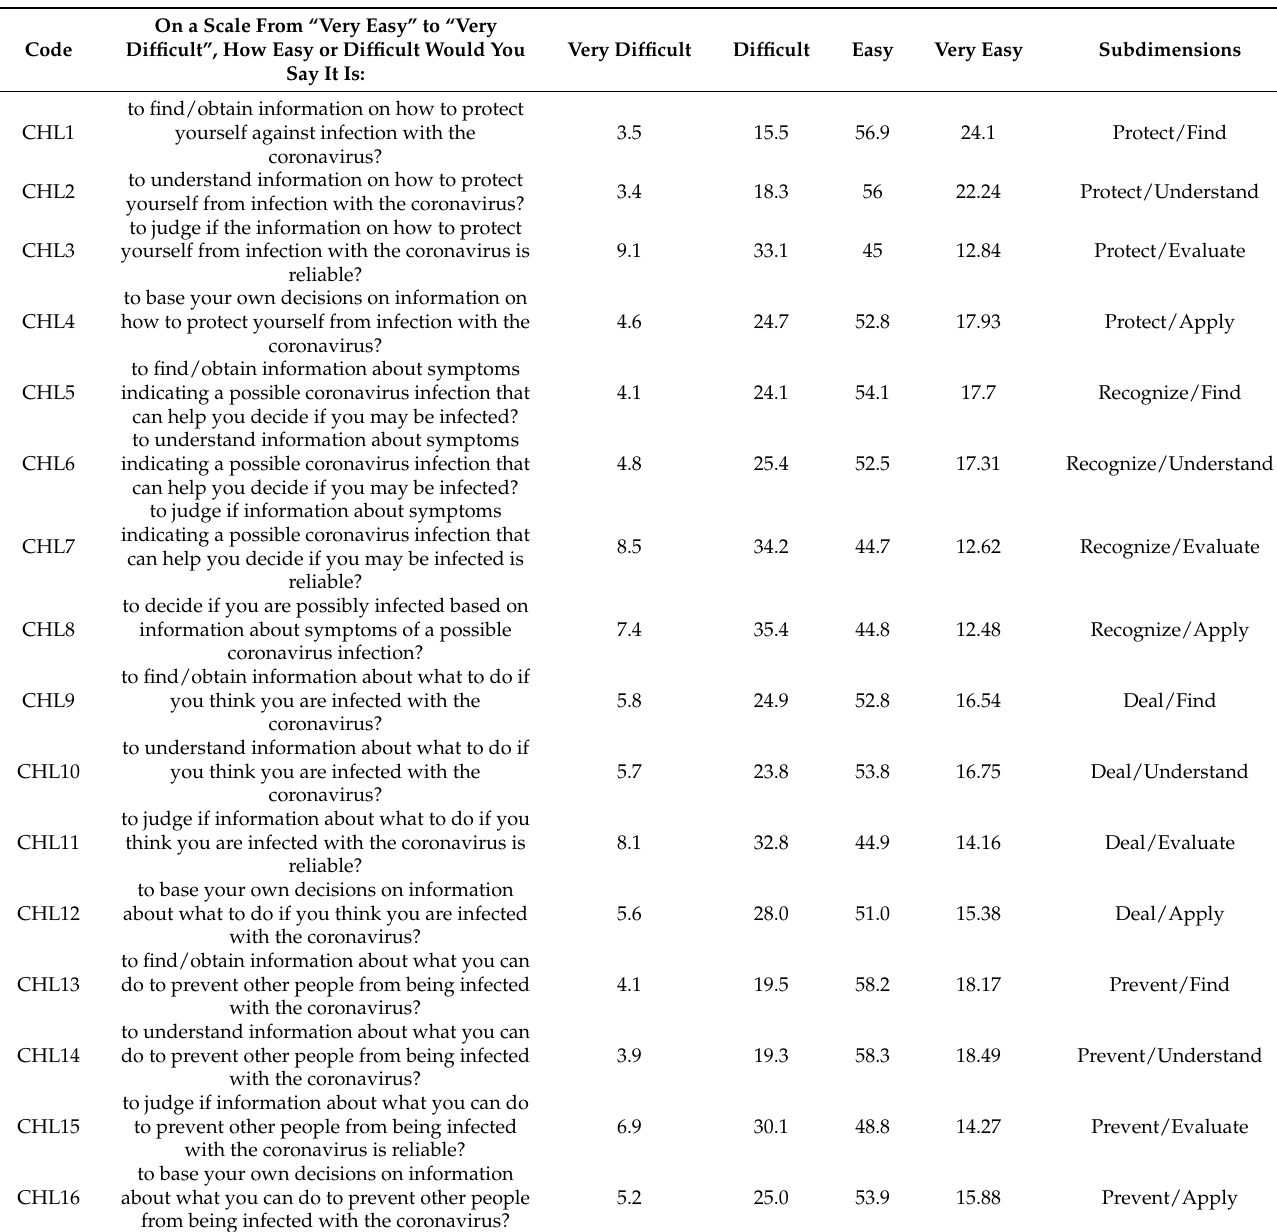
Table 2. Percentages of respondents by category and type of question of the “Corona Health Literacy